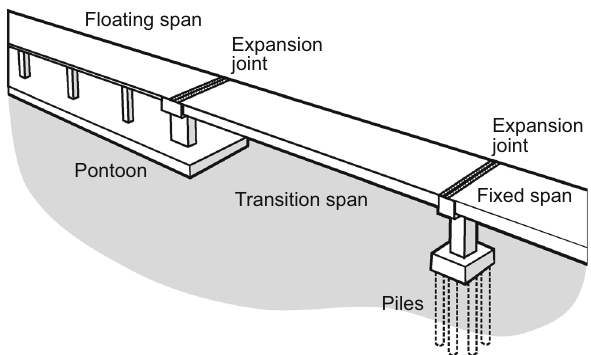
Fig. 1 Fixed, transition and floating spans of the Homer M. Hadley Bridge